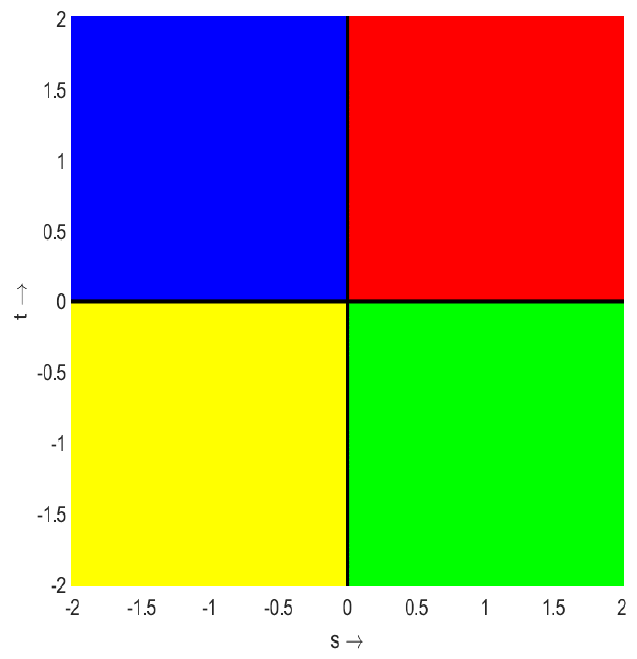
Figure 8. Dynamics of the method (3) associated with BA of Example 6.